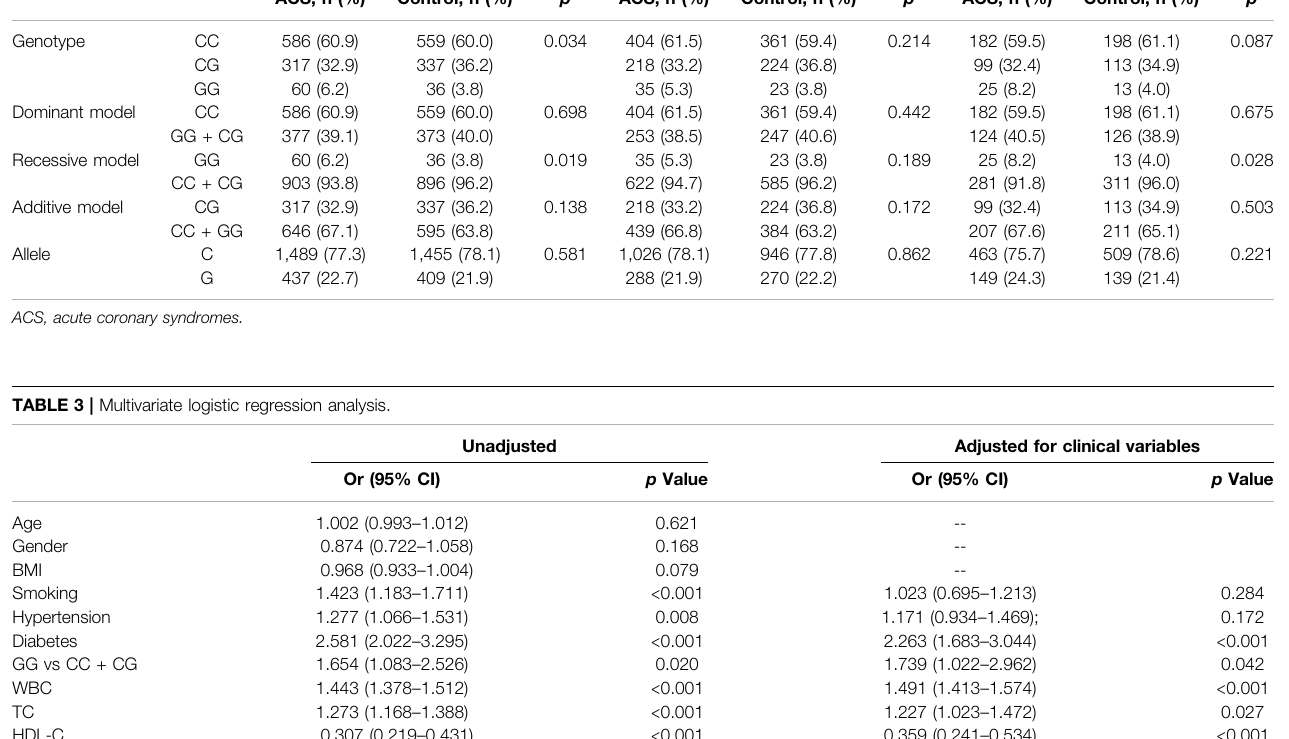
TABLE 2 | Distribution of genetic variation of MIF gene rs2070766 in the study population. Total Male Female ACS, n (%) Control, n (%) p ACS, n (%) Control, n (%) p ACS, n (%) Control, n (%) p